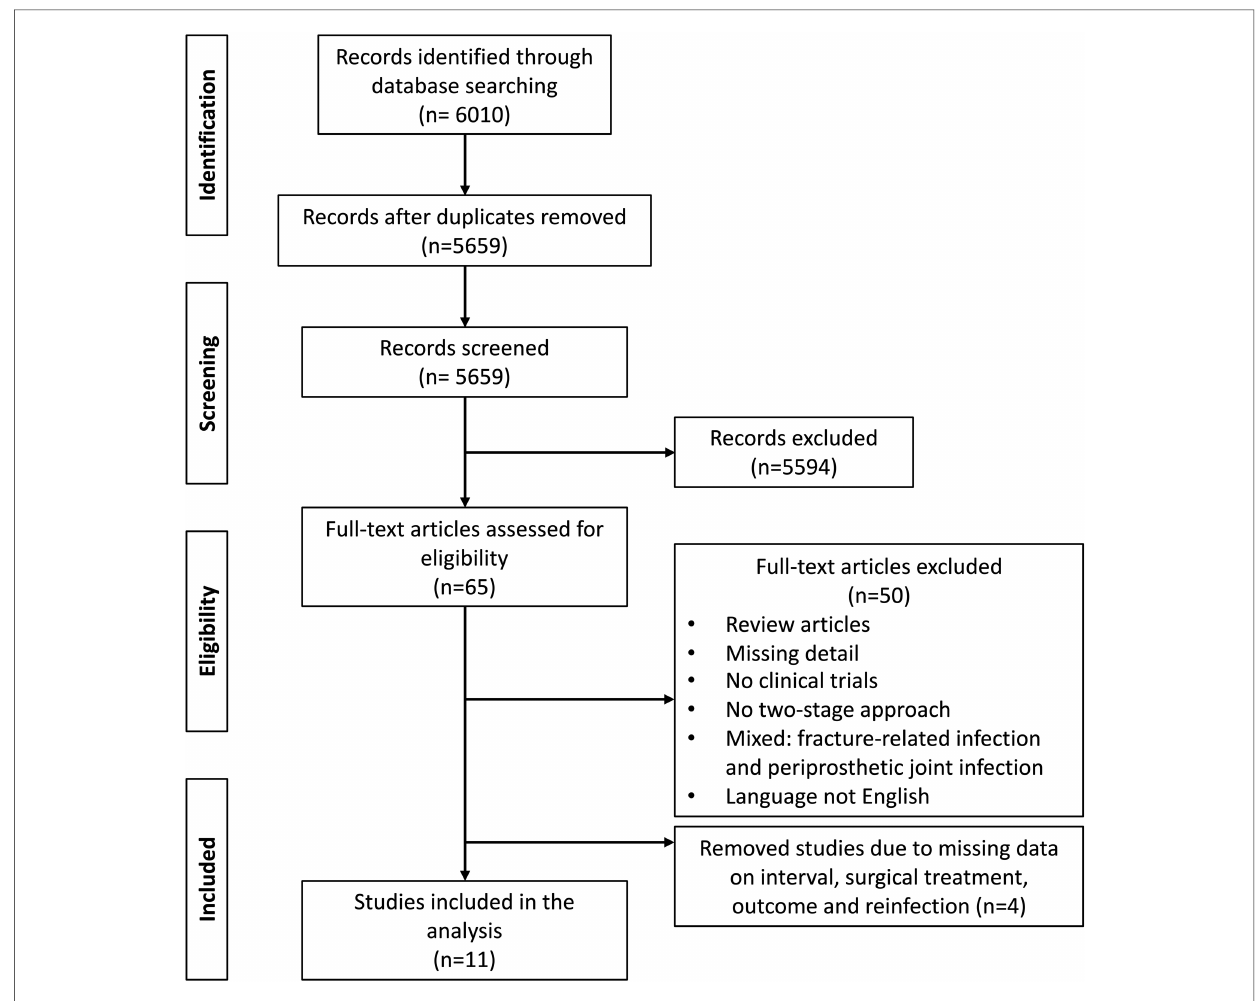
FIGURE 1 Preferred reporting items for systematic reviews and meta-analyses (PRISMA) fl ow diagram: eligibility